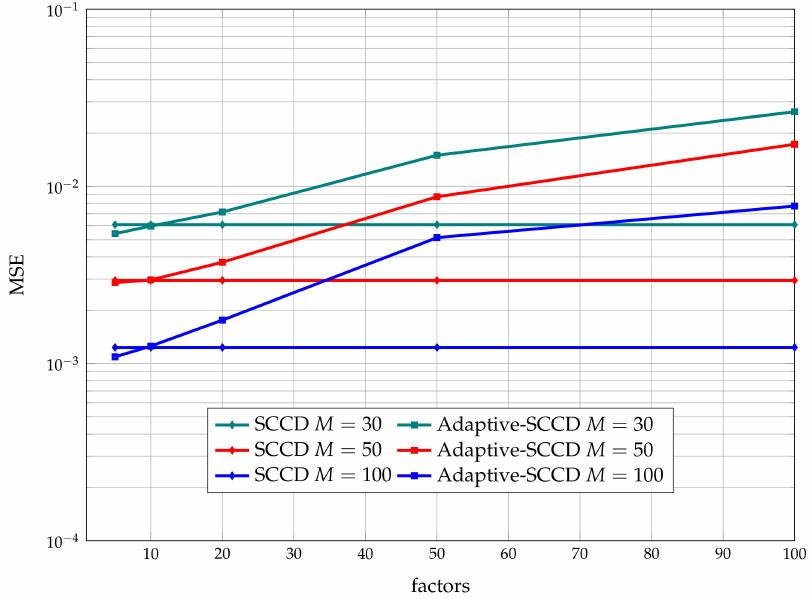
Figure 4. MSE versus factors for a scenario with SNR = 10 dB and p = 5 normalized frequencies.